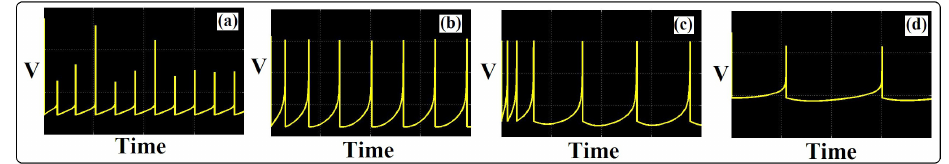
Figure 8. Output voltage of the proposed ADEX neuron implemented on the FPGA board. ( a ) can. ( b ) cAD. ( c ) Initial bursting. ( d )